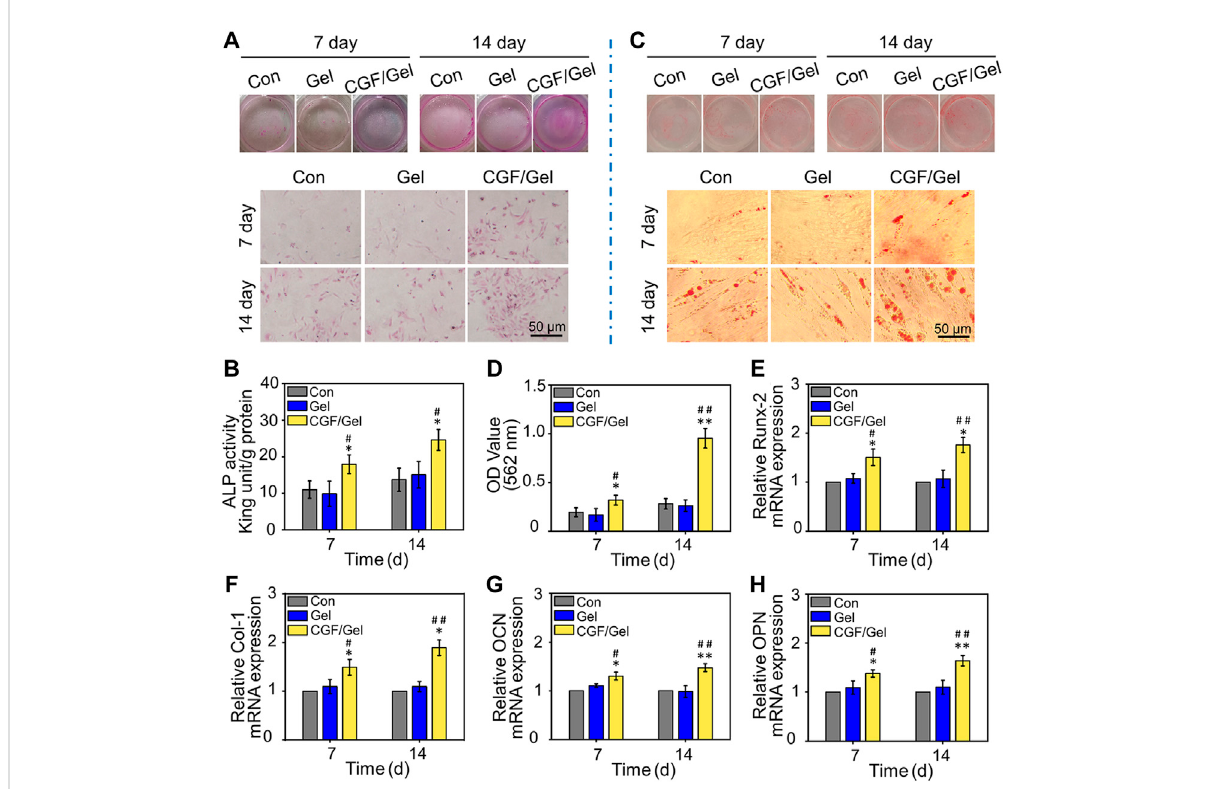
FIGURE 3 (A) Representative visual and microscopical images of ALP staining after 7 and 14 days of osteogenic induction. (B) Quantitative analysis of ALP activity of BMSCs ( n = 3). (C) Representative visual and microscopical images of Alizarin Red staining to assess cell mineralization after 7 and 14 days of osteogenic induction. (D) Semi-quantitative analysis of alizarin red staining of BMSCs ( n = 3). (E – H) The expression of osteogenic-related genes ( Runx-2 , Col-1 , OCN , and OPN ) in BMSCs after osteogenic induction for 7 and 14 days ( n = 3) (* p < 0.05, ** p < 0.01 compared with Con group; # p < 0.05, ## p < 0.01 compared with Gel